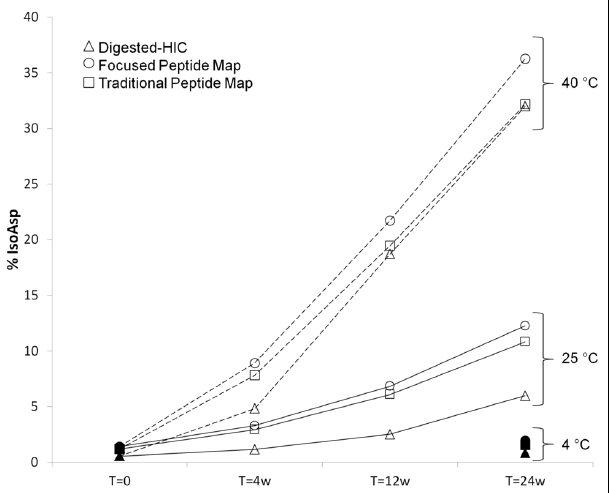
FIGURE 6 | Comparison of percent isoAsp determined by digested-HIC ( (cid:2) ), UV integration from a focused peptide map ( (cid:2) ), and total ion area from a longer traditional peptide map ( (cid:2) ). Samples were held at 4 ◦ C (filled symbols), 25 ◦ C (solid line), or 40 ◦ C (dashed line) for up to 24 weeks. Samples at 4 ◦ C for 4 weeks and 12 weeks were not tested due to the slow rate of isoAsp formation at this